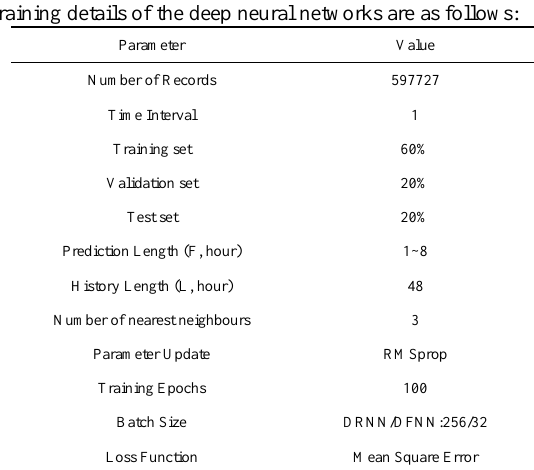
Table 4. Structures of deep neural networks